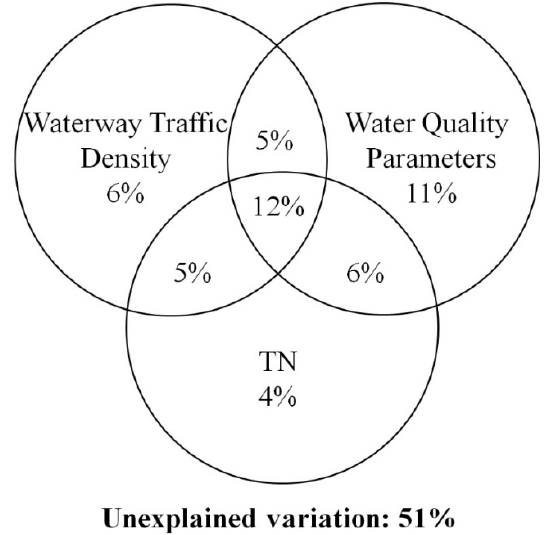
Figure 6. Variation partitioning of specific effects within the matrix of benthic macroinvertebrate abundances and the shared variation of each environmental parameter (total nitrogen and other water quality parameters).